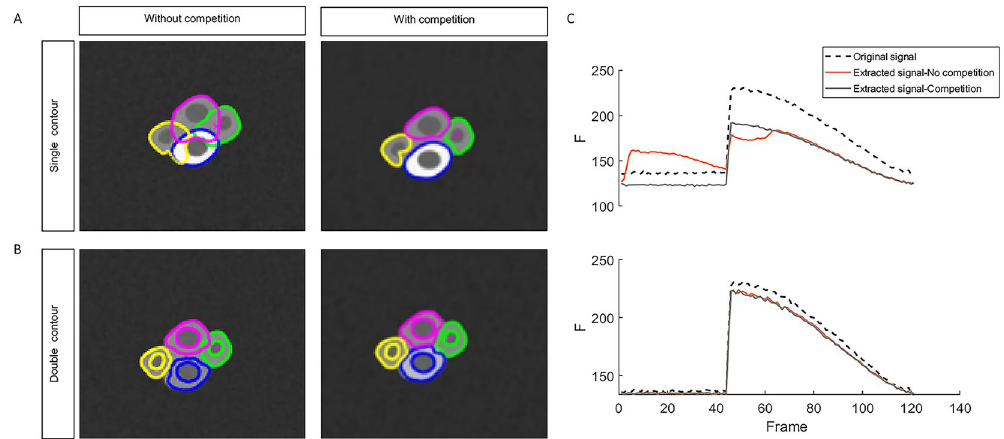
Figure 4. Tracking of overlapping cells with the same base intensity level during rest and different intensity levels during activity using ( A ) one-layer contours without a competition parameter (left) and with a competition penalty added (right) and ( B ) double contours without a competition parameter (left) and with a competition penalty added (right) ( C ) Extracted signals from a cell using one-layer contours (top) and double contours